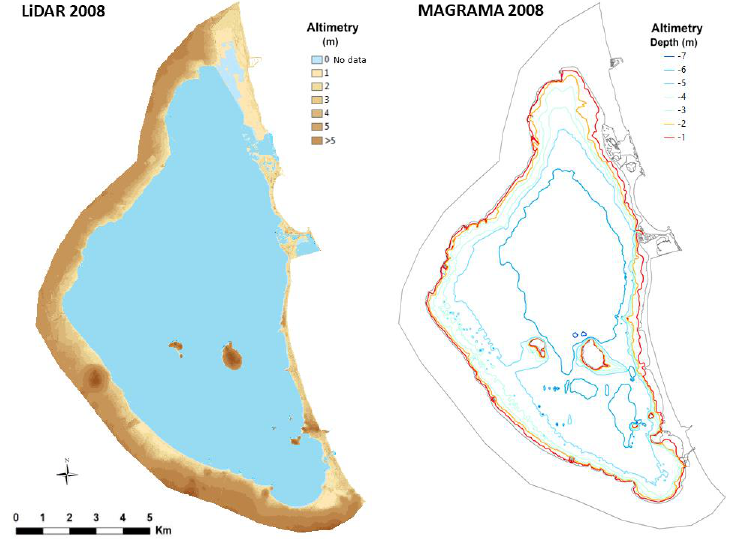
Figure 5. LiDAR data (2008) around the Mar Menor lagoon and MAGRAMA bathymetry in 2008.